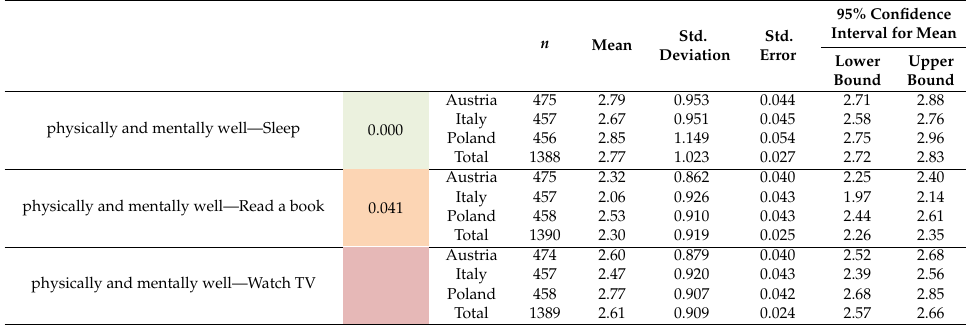
Table 5. Activities in the case of mental and physical well-being (green = highly significant differences, orange = significant differences, red = no significant